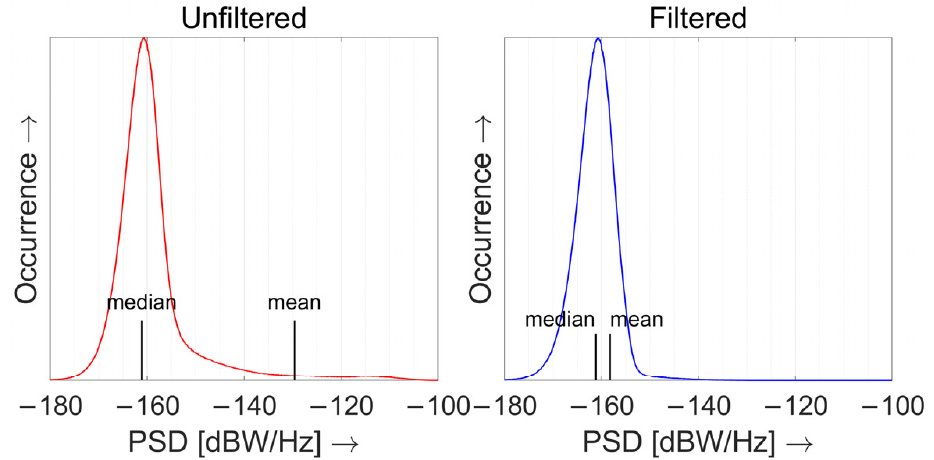
Figure 12. Probability distribution of the measured power spectral density (PSD) before (left) and after adaptive filtering (right).